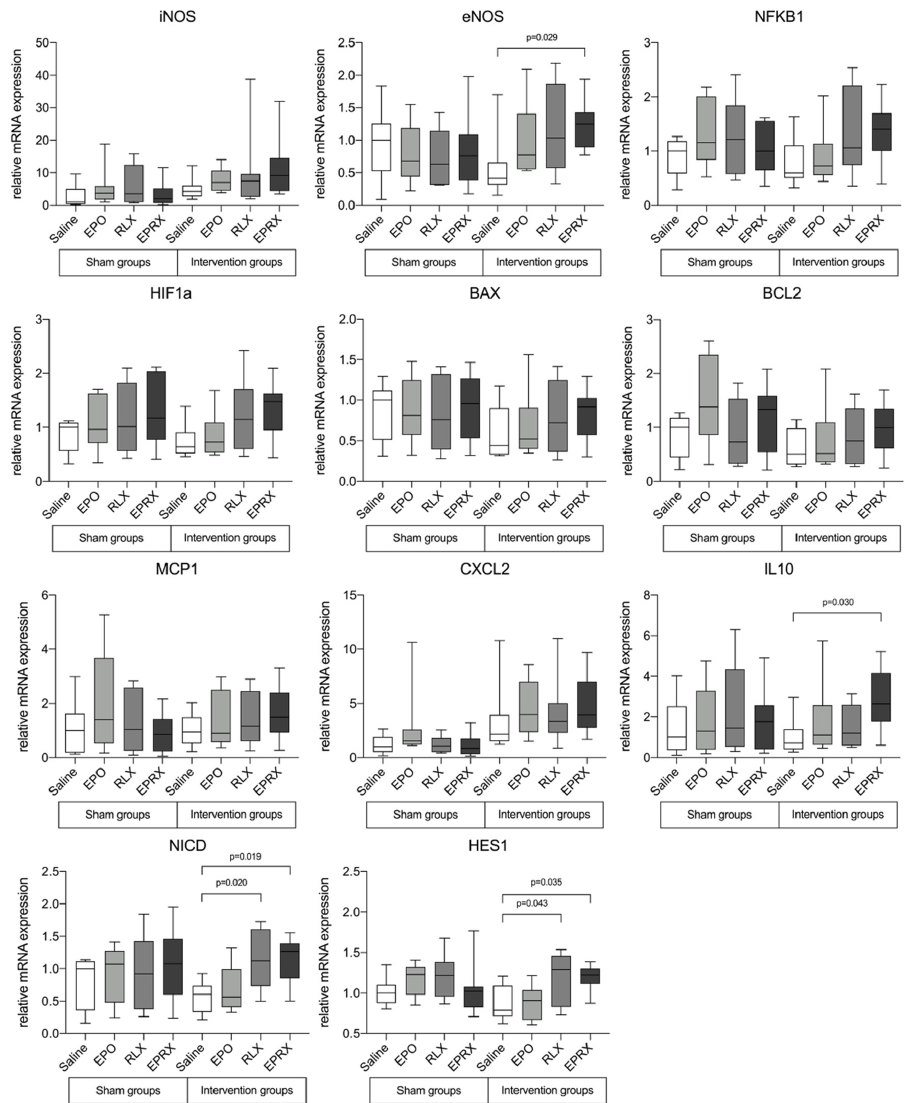
Figure 3. Quantitative RT-PCR of mRNA expression of iNOS, eNOS, NFKB1, HIF1A, BAX, BCL2, MCP1, CXCL2, IL10, NICD and HES1. Data were normalized to GAPDH gene expression. EPO—erythropoietin, RLX—relaxin, EPRX—erythropoietin with relaxin. Data are shown as median (Q1, Q3). The Kruskal–Wallis test was used in all cases.